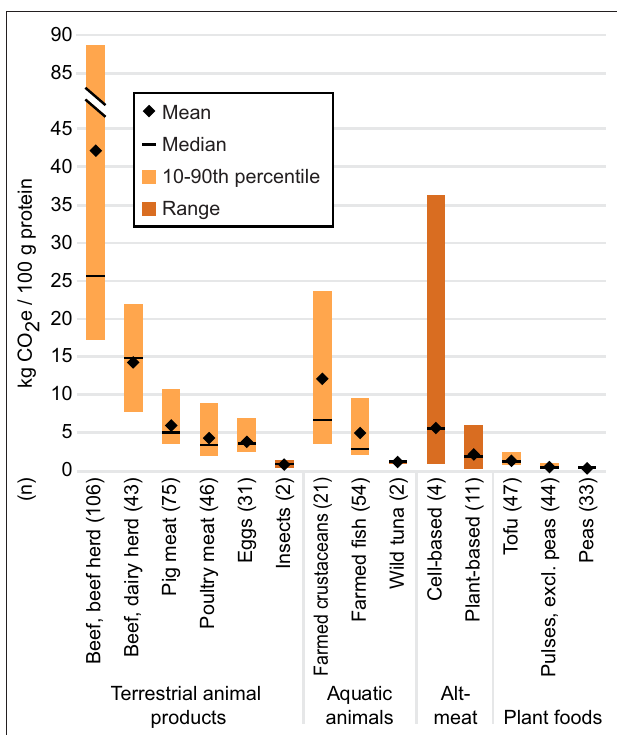
FIGURE 3 | Cradle-to-processing gate GHG footprints (wherever possible) per 100g protein. For cell-based meat, plant-based substitutes, insects, and wild tuna, the mean and median were calculated using the mean value from each individual study ( n ) to avoid over-representing results from studies that included more products than other studies. The minimum and maximum values of the range were derived from individual product footprints. For data sources and individual product footprints, see Supplementary Data . Data for all other foods are from Poore and Nemecek (2018); for these n represents the number of